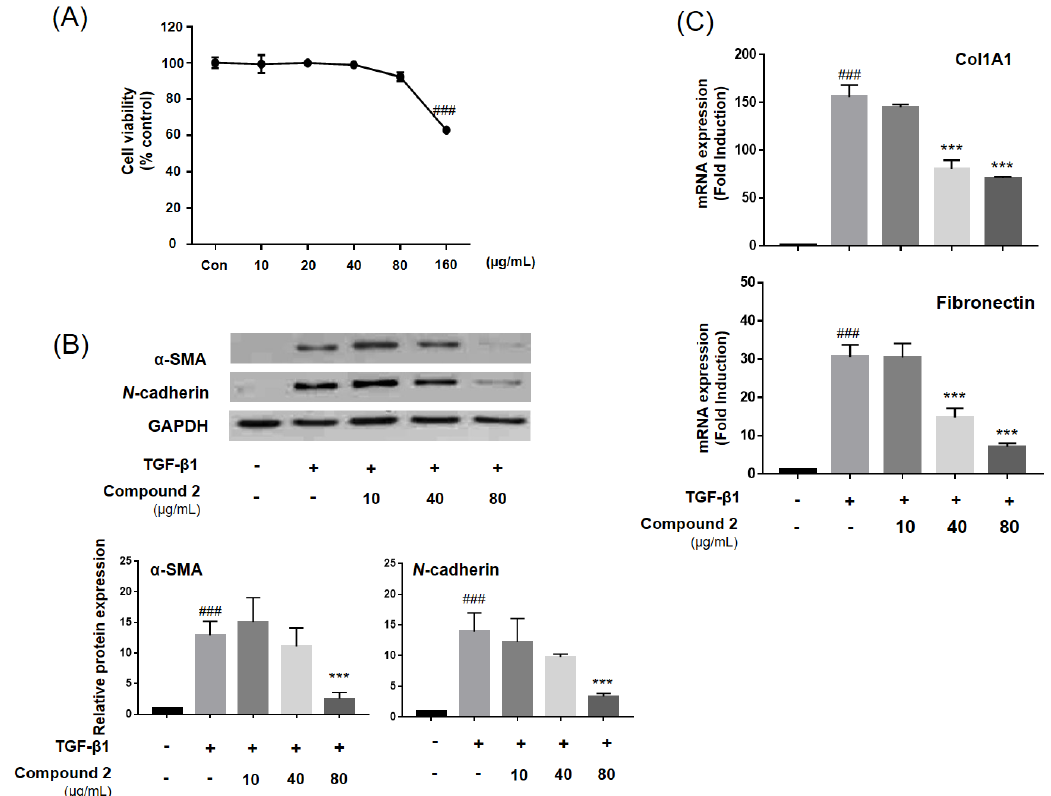
Figure 4. Compound 2 ameliorate TGF-β1-induced myofibroblast differentiation in alveolar epithelial A549 cells. A549 cells were treated with TGF-β1 (2 ng/mL) and compound 2 for 48 h. ( A ) A549 cells. A549 cells were treated with TGF- β 1 (2 ng/mL) and compound 2 for 48 h. ( A ) Cytotoxicity Cytotoxicity of compound 2 in A549 cells was measured by WST-1 assay at 48h. Compound 2 was treated to A549 cells. ( B ) The protein expression of α-SMA and N -cadherin was analyzed by western blot. ( C ) Expression of collagen (Col1A1) and fibronectin was analyzed by qPCR-analysis. All the